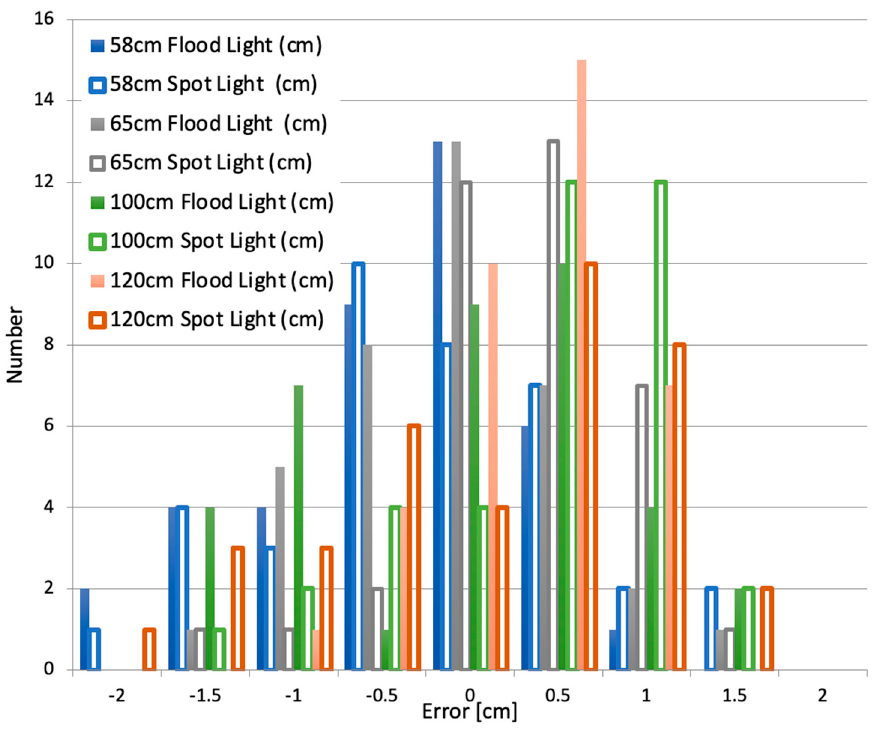
4.3. ROC Curves for Detection Assessment in Laboratory Figure 19 plots the distributions of errors for each protocol. For discrete values, we estimated the probabilities by computing statistical frequencies [37]. ROC curves are plot- ted in Figure 20. Protocols with spot light are among the worst ones.